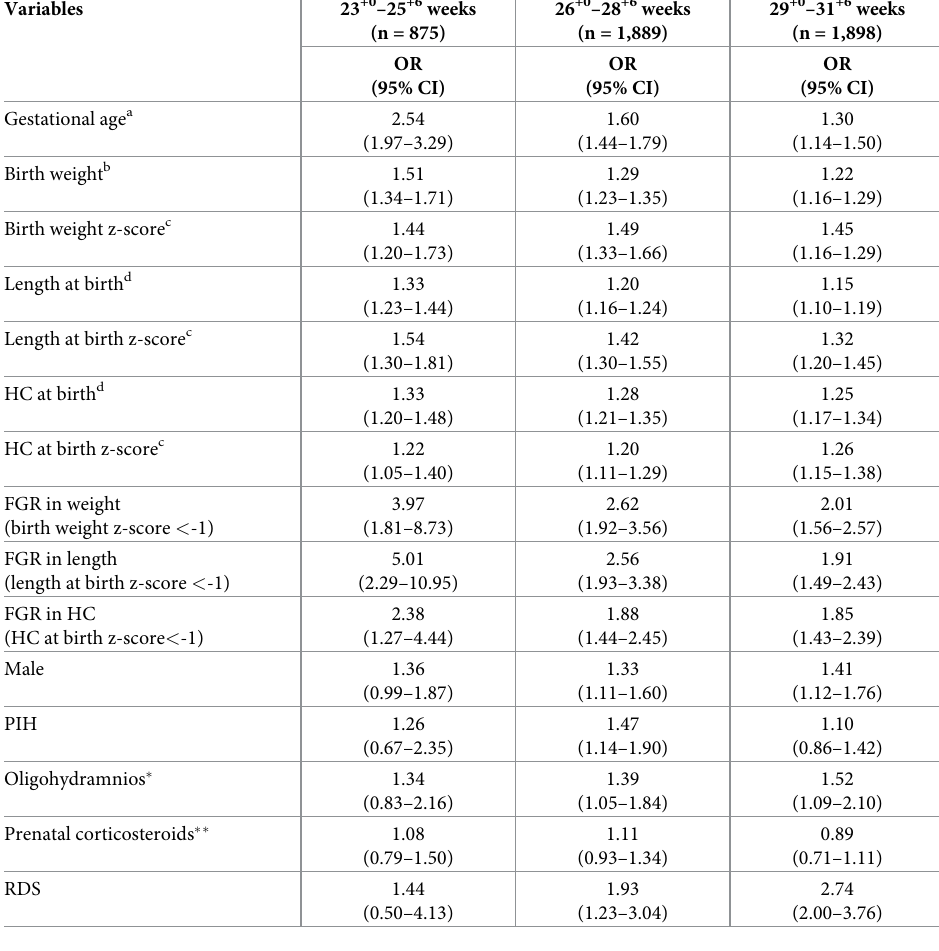
Table 2. Univariate analysis of the associations of the anthropometric measurement values at birth, and the asso- ciations of the maternal and neonatal characteristics with BPD or death before 36 weeks postmenstrual age in each gestational age